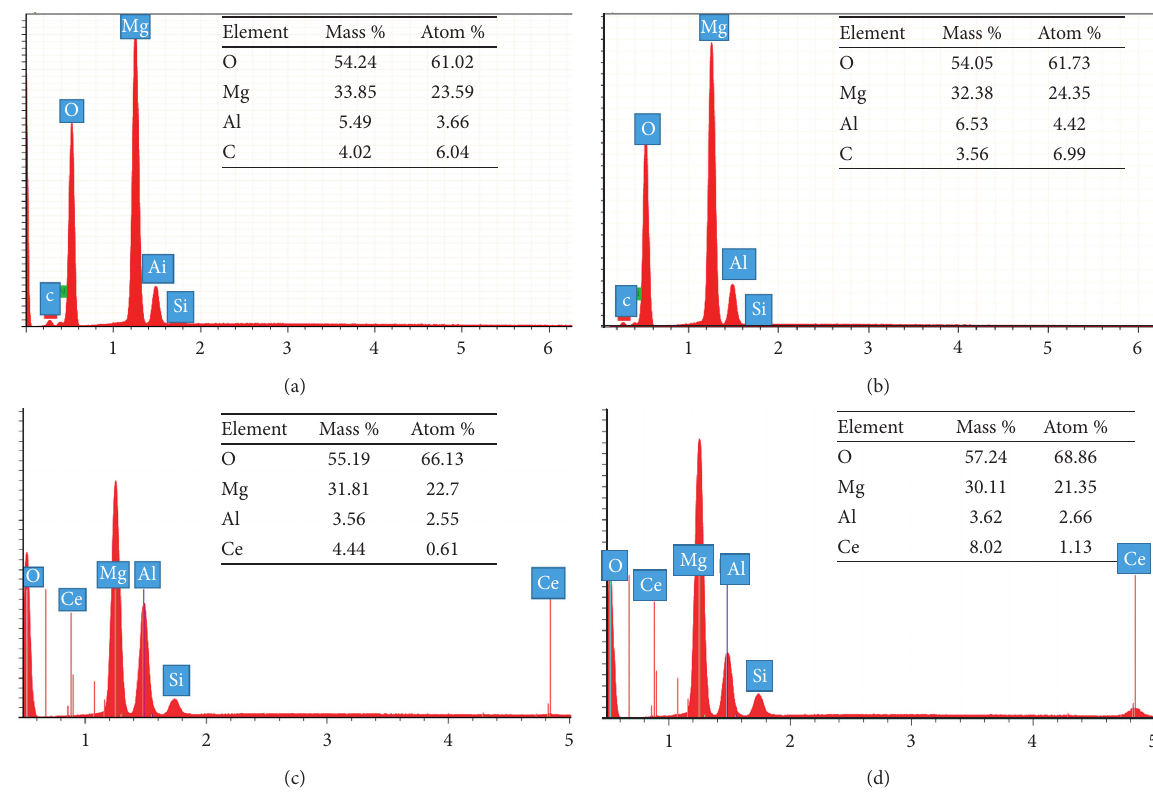
Figure 4: EDS spectra of the developed films and respective quantitative analysis: (a) LDH, (b) LDH-H, (c) CeLDH, and (d) CeLDH-H.